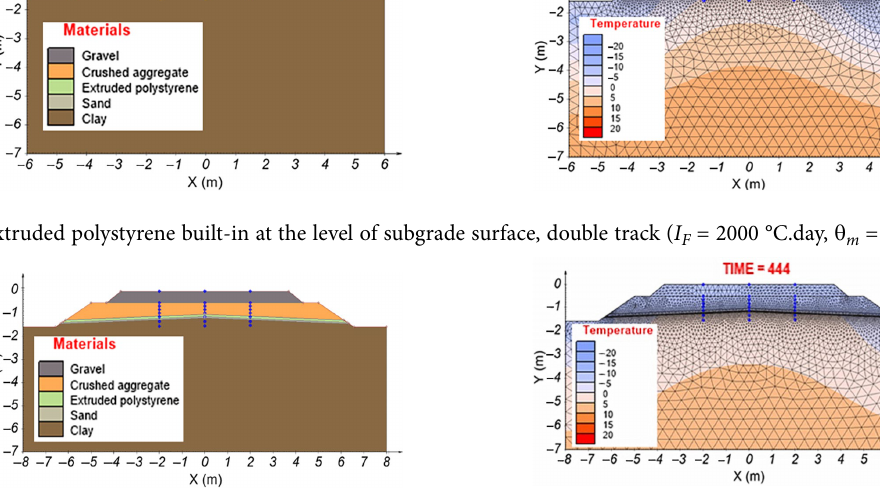
Figure 6. Overview of created models for assessment of various input modelling parameters (images on the left) and the corresponding days of the numerical model with a maximum achieved freezing depths of the railway track structure (images on the right) Table 5. Achieved depths of freezing of the railway track structure corresponding to the numerical models depending on different climatic loads Model no.